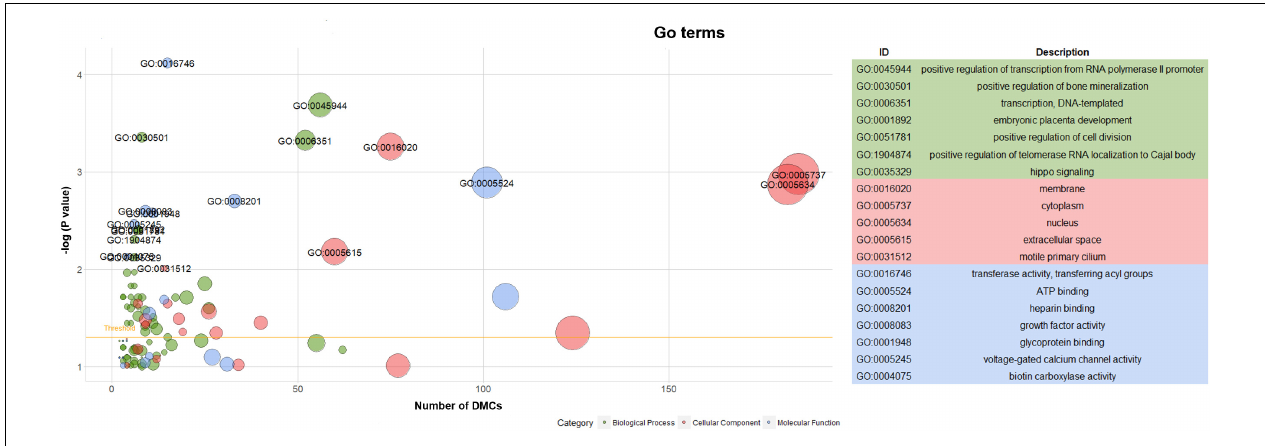
FIGURE 6 | Go term analysis of genes associated with DMCs. Note: Yellow line in the left panel meant the threshold of significant GO terms ( P <